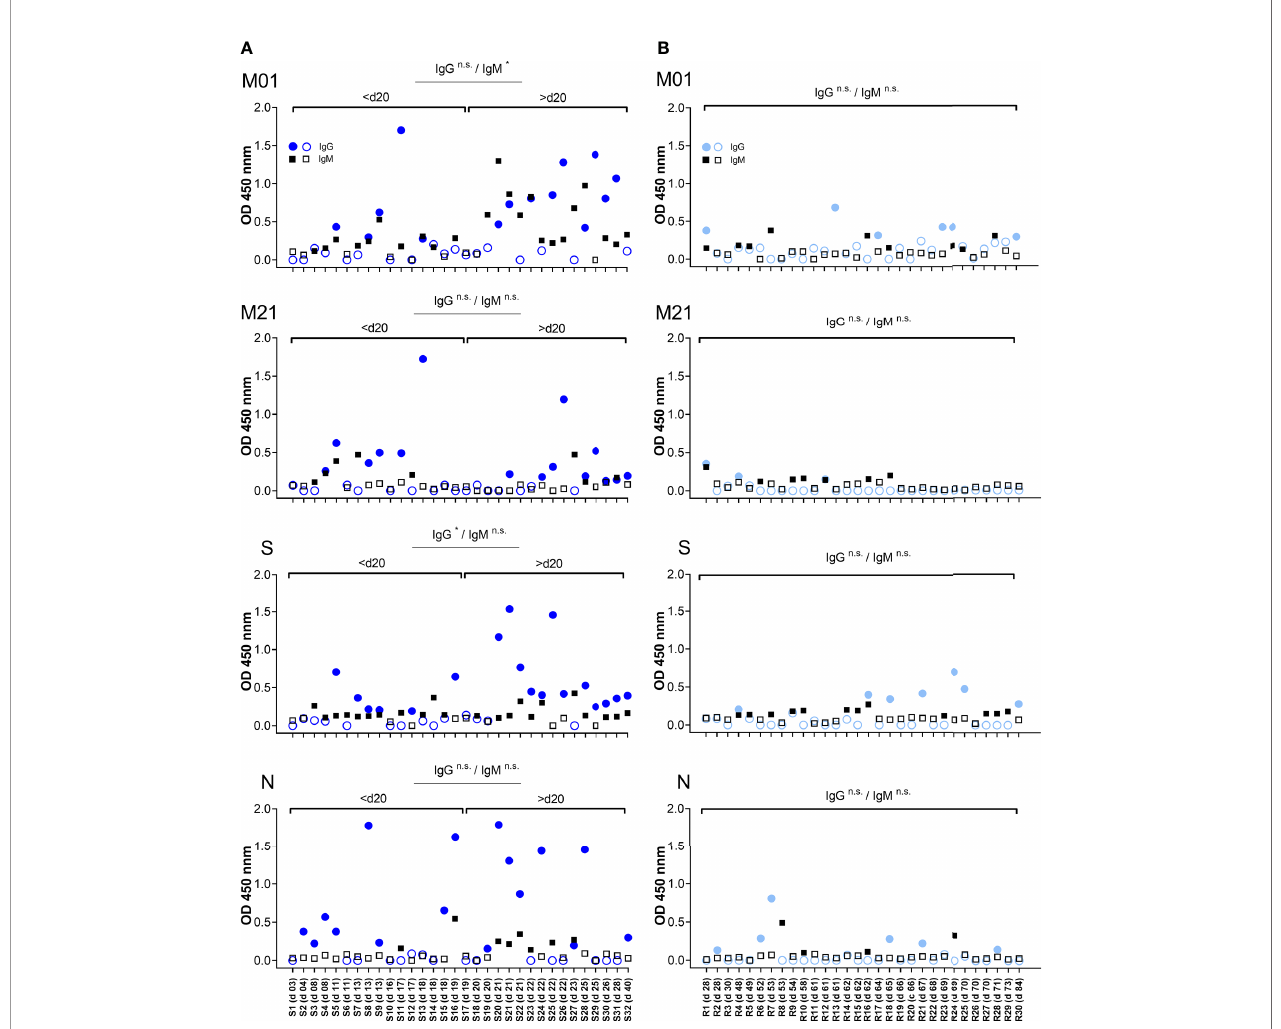
FIGURE 3 | Temporal antibody binding to immunodominant epitopes of SARS-CoV-2. Data are depicted for patients from the acute (A) and convalescent phase (B) . Plasma samples are arranged according to days PIO (from low to high). Each data point represents the OD450 value observed for one patient and at a given time point PIO. Filled symbols (circle, square) indicate OD450 values above individual threshold. X axis represents COVID-19 patient number (S01-S32 and R01-R30 for acute and convalescent phase, respectively) and days PIO. Signi fi cance of the IgG and IgM antibody response is indicated for time periods before/after day 20 PIO. n.s., not signi fi cant.